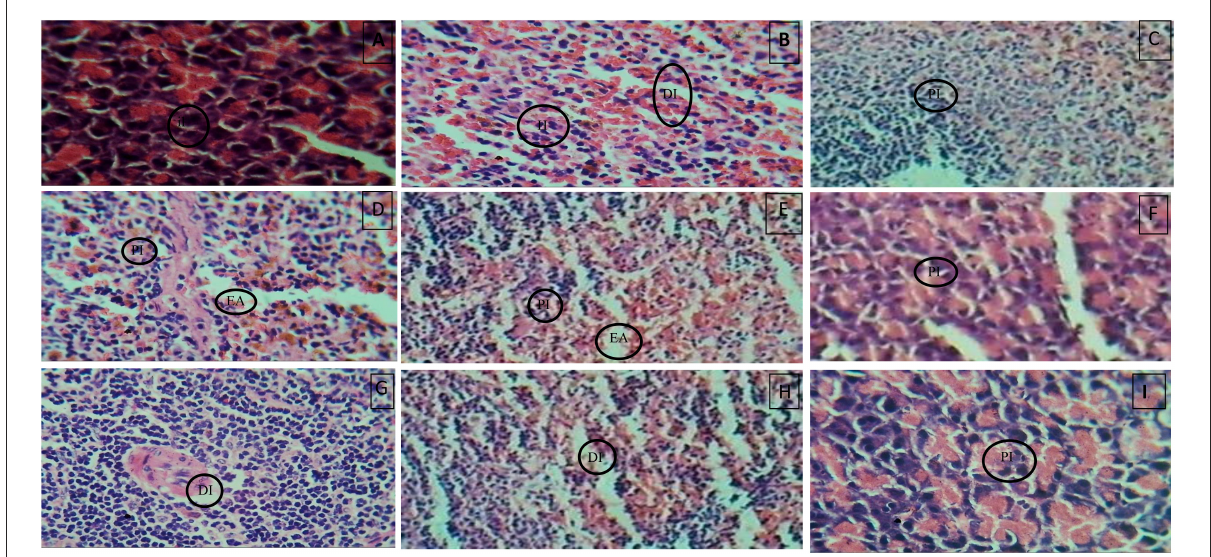
FIGURE9 (A) Normal control, (B) Diseased, (C) Pioglitazone 3.98 mg/kg, (D) Metformin 44.29 mg/kg, (E) Glimepiride 0.18 mg/kg, (F) Acarbose 8.86 mg/kg, (G) B. aurea 100mg/kg, (H) B. aurea 200 mg/kg, and (I) B. aurea 400 mg/kg. Note: IL, Islets of Langerhans; DI, Depleted islets; H, Hemorrhage; PI, Preserved islets; EA, Exocrine acini.